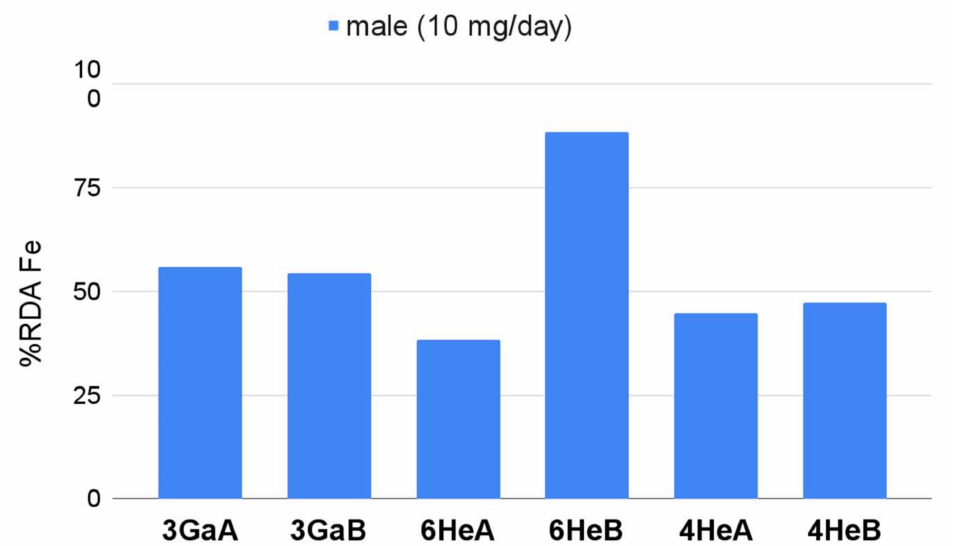
Figure 1. Realisation of dietary recommendations for Fe by iron-enriched beetroot-based dietary supplements. Recommendations for male (10 mg/day) were applied according to Jarosz et al. [27].